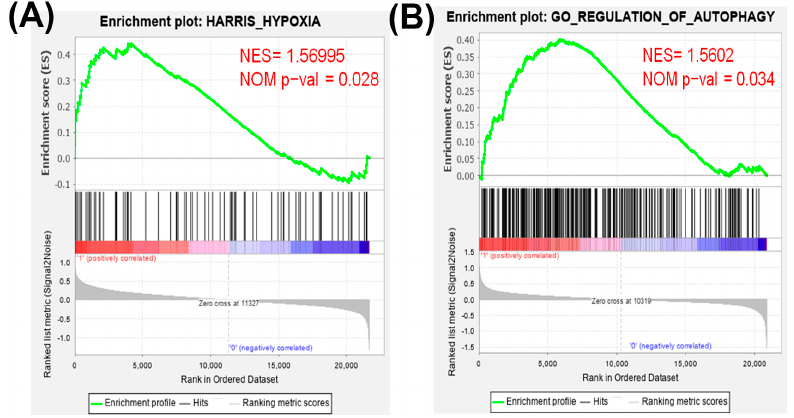
Figure 1. Gene set enrichment analysis (GSEA) of hypoxia and autophagy gene expressions in primary tumors and normal tissues derived from patients with triple-negative breast cancer (TNBC). All of the expressed genes were uploaded into GSEA for enrichment analysis. The Harris hypoxia ( A ) and Gene Ontology (GO) regulation of autophagy ( B ) gene sets database were used as the gene set collection for analysis. NES, normalized enrichment score; NOM p-val, nominal p